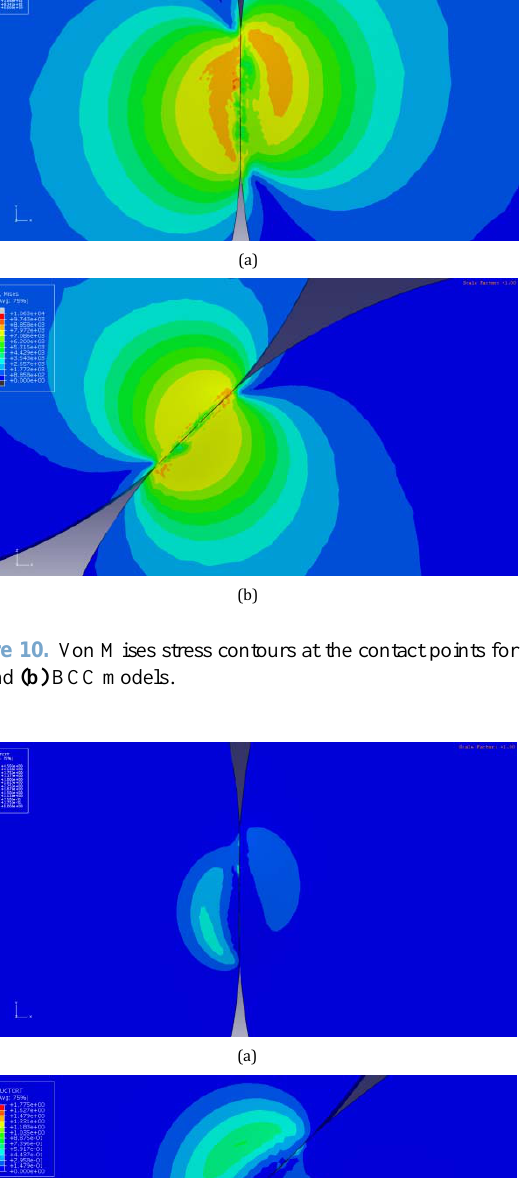
Table 3. Mass removal